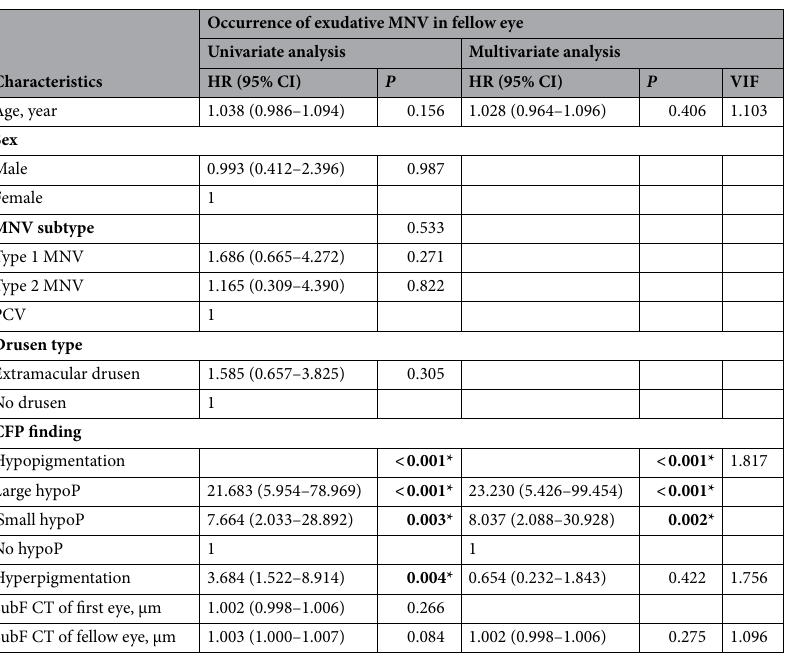
Table 3. Cox proportional hazard model using color fundus photography findings for occurrence of fellow eye exudative macular neovascularization in patients with unilateral exudative macular neovascularization and fellow eye without significant drusen. Significant values are in bold. MNV = Macular neovascularization; PCV = Polypoidal choroidal vasculopathy; CFP = Color fundus photography; hypoP = Hypopigmentation; SubF = Subfoveal; CT = Choroidal thickness; HR = Hazard ratio; CI = Confidence interval; VIF = Variance inflation factor. *Significantly